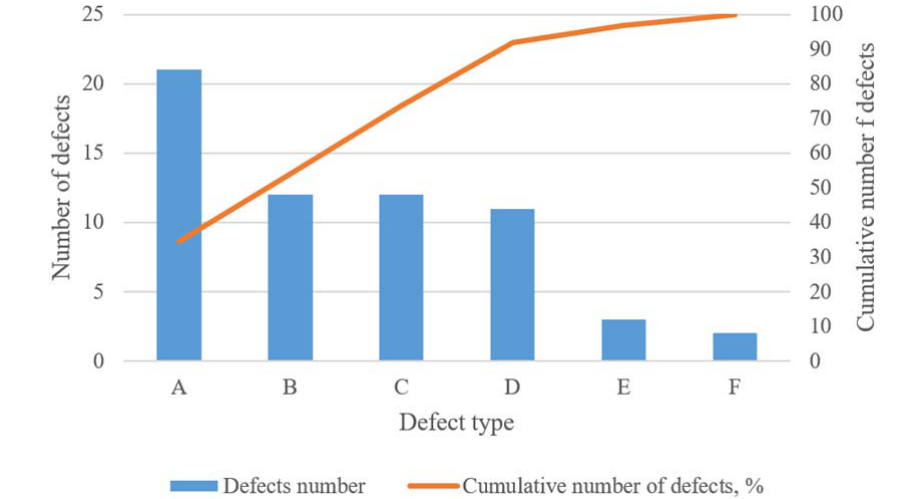
Figure 1. Pareto chart . The cumulative weight of Calarasi variety walnuts